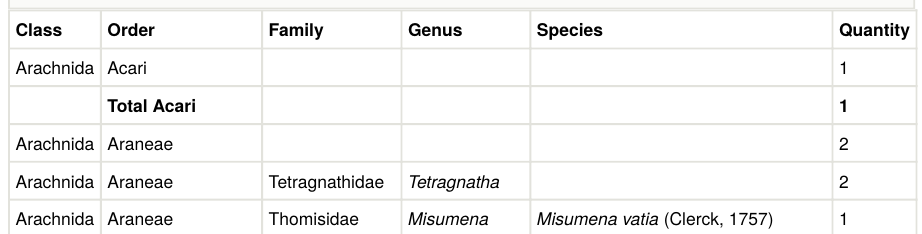
Composition of sweep net samples as determined by sight identi fi